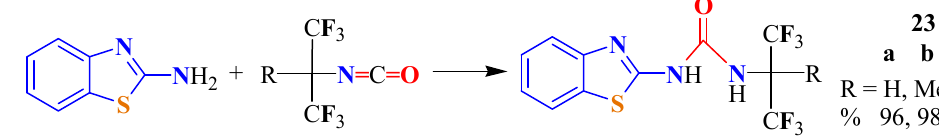
Figure 4. N -bis(trifluoromethyl)alkyl-UBTs 23a – c from 2ABT and fluoroalkyl isocyanates.